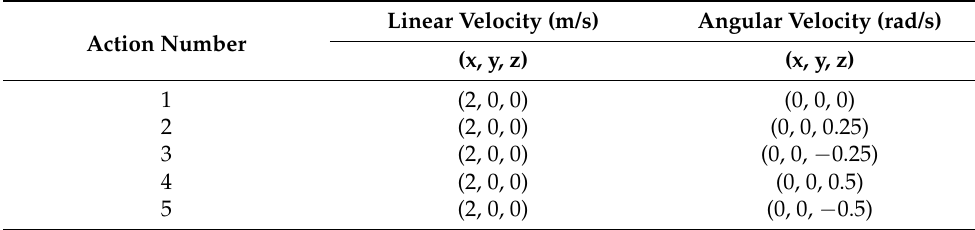
Table 4. Quadrotor Action